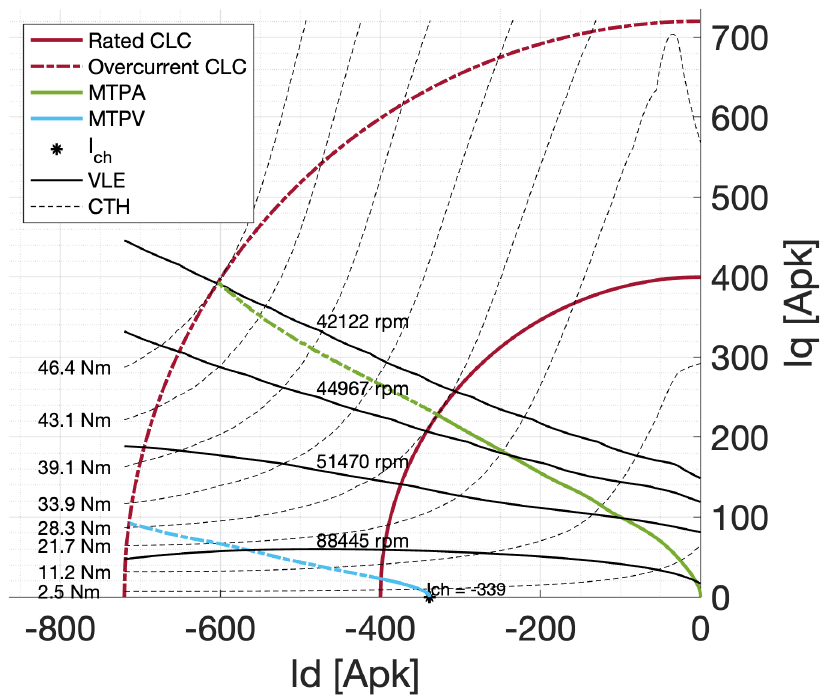
Figure 10. Control trajectories on the d-q plane computed with FP.